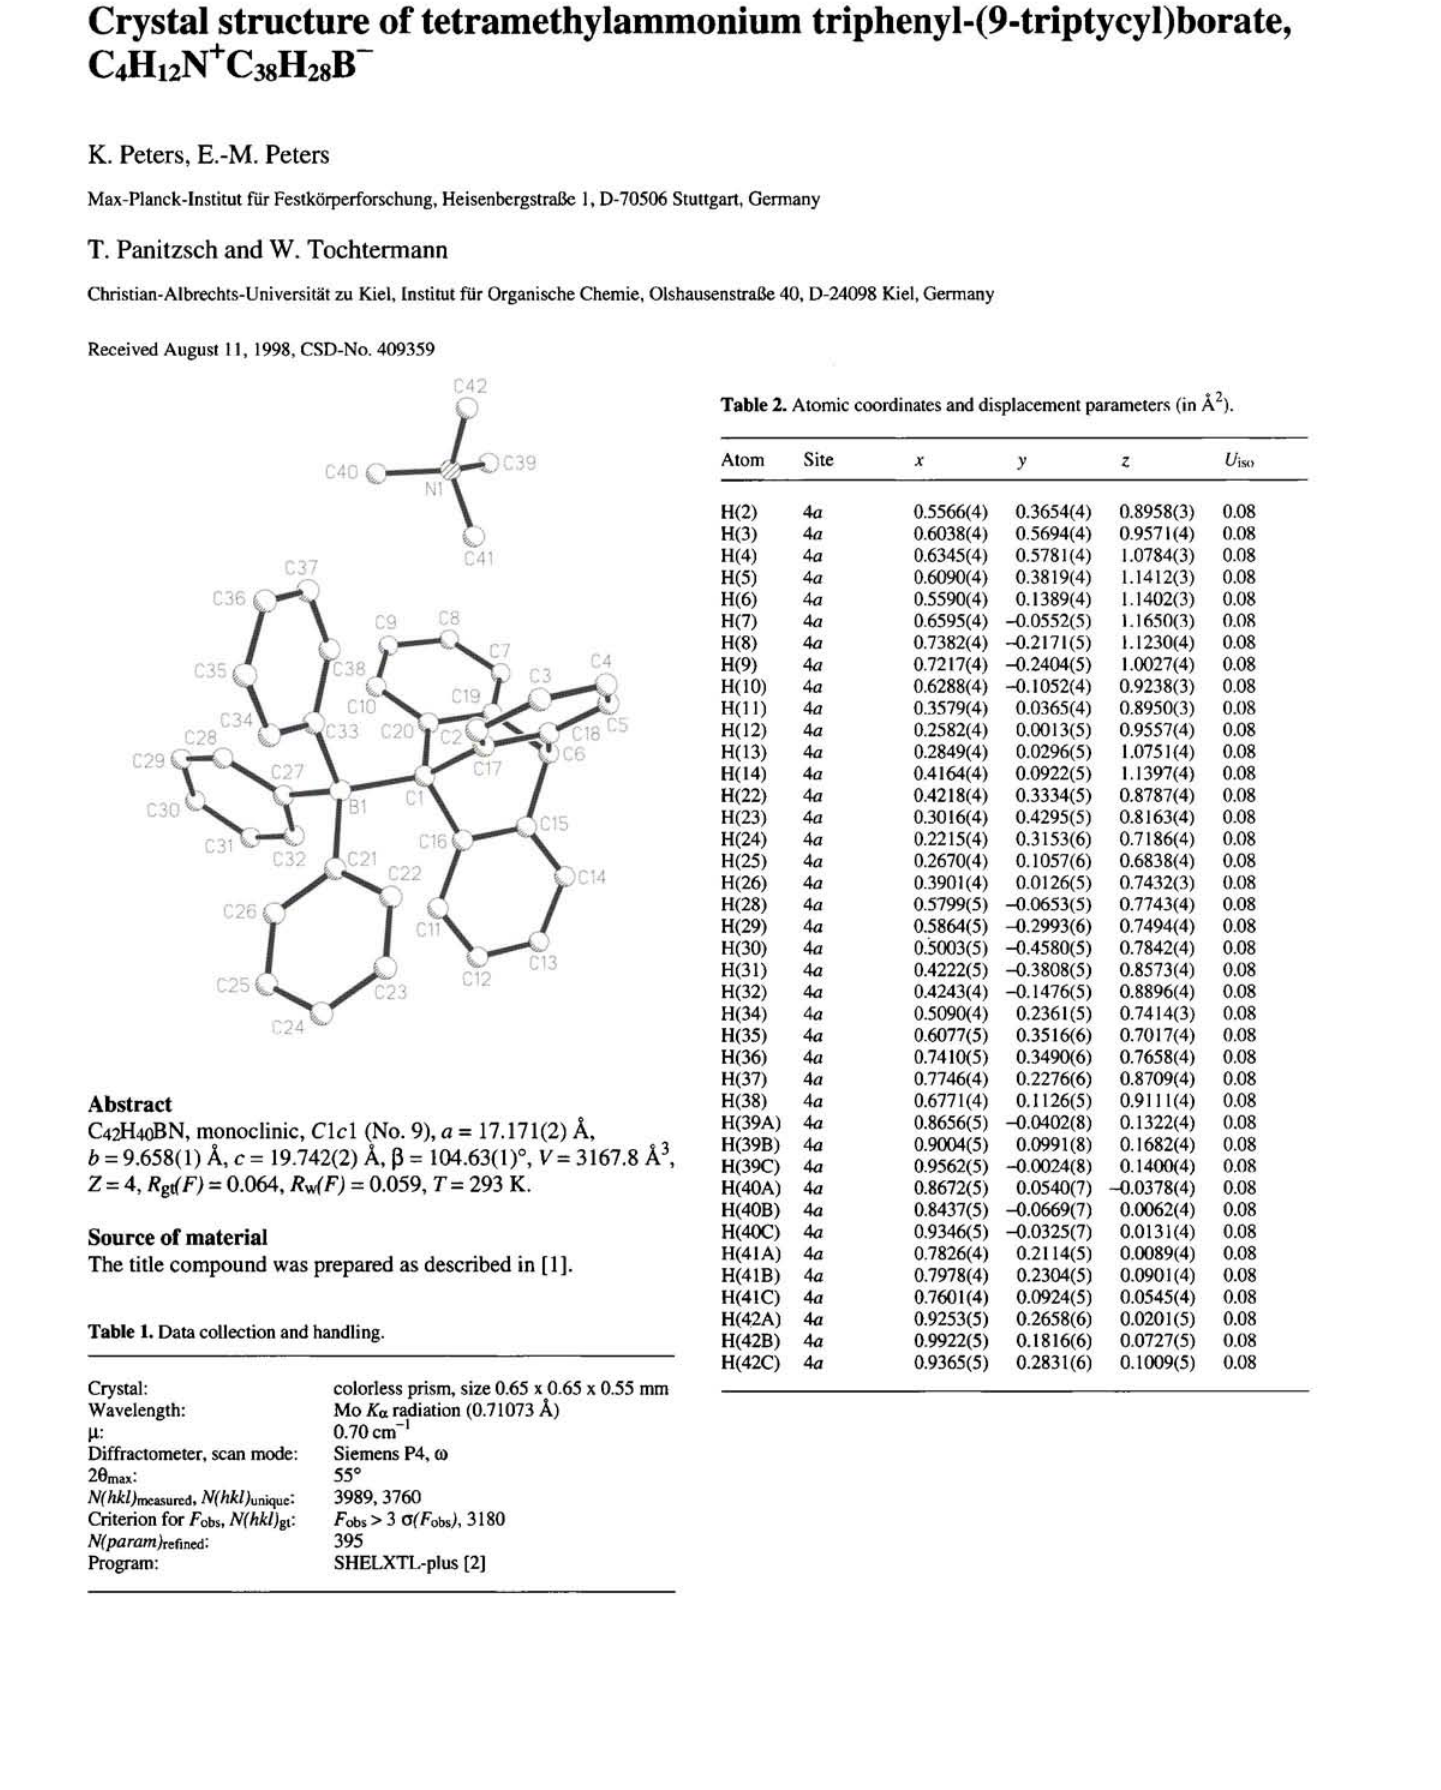
Table 1. Data collection and